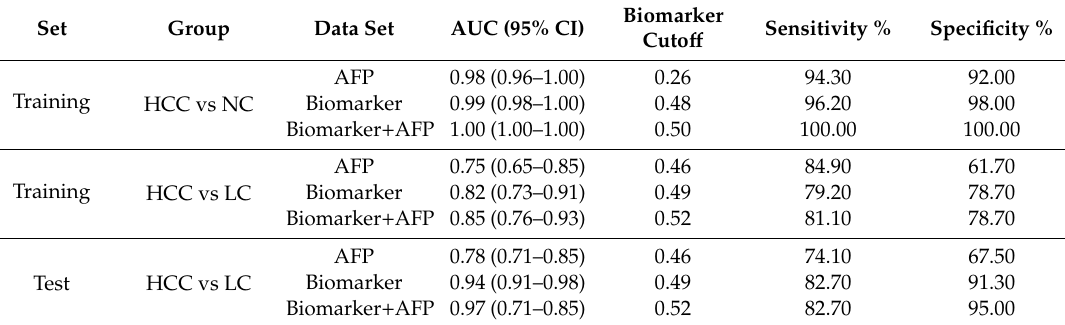
Figure 3. Power of the biomarker panel to discriminate HCC from LC, as assessed using the logistic regression model. ( a ) Receiver operating characteristic (ROC) curves for the training set. ( b ) ROC curves for the validation set. The blue-, red-, and green-colored lines indicate AFP, metabolic biomarkers, and metabolic biomarkers with AFP, respectively. AUC, area under the receiver operating curve; HCC, hepatocellular carcinoma; LC, liver cirrhosis; AFP, α -fetoprotein. Table 2. Test performance characteristics for the biomarker signature from the training and test set.